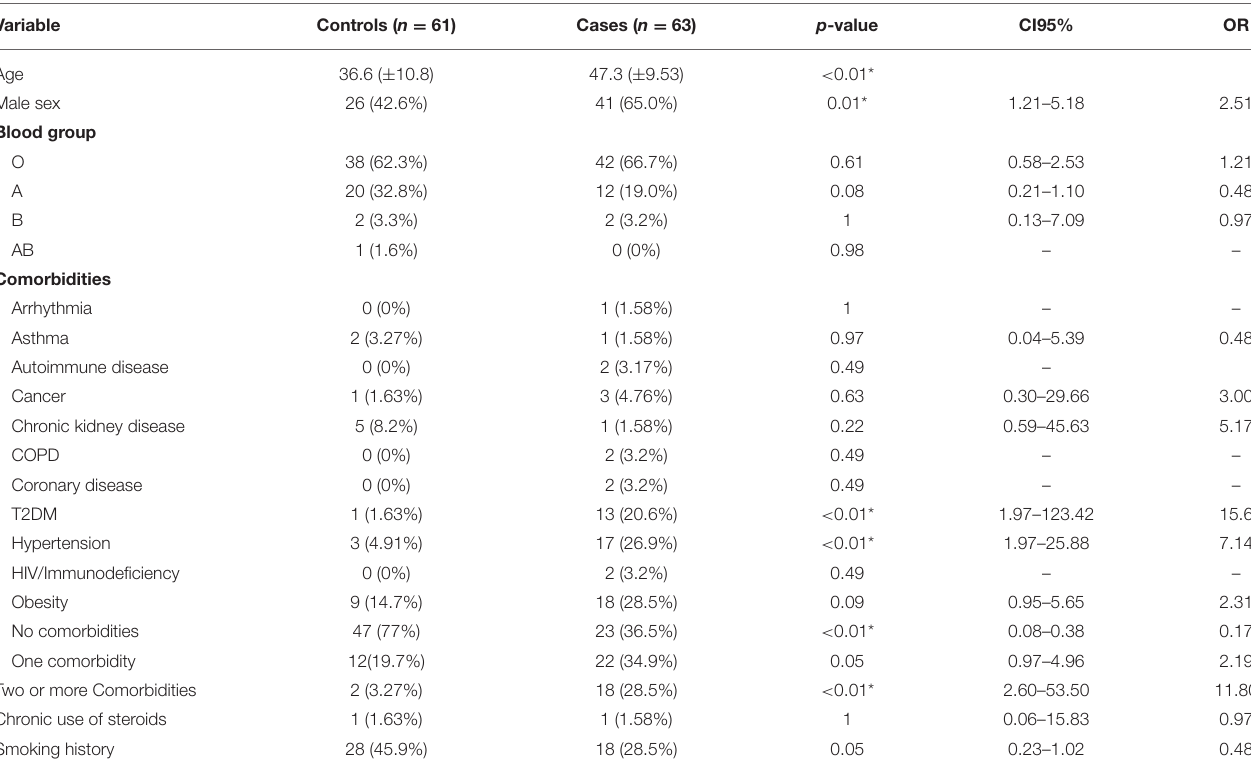
TABLE 1 | Demographic and clinical characteristics of the study